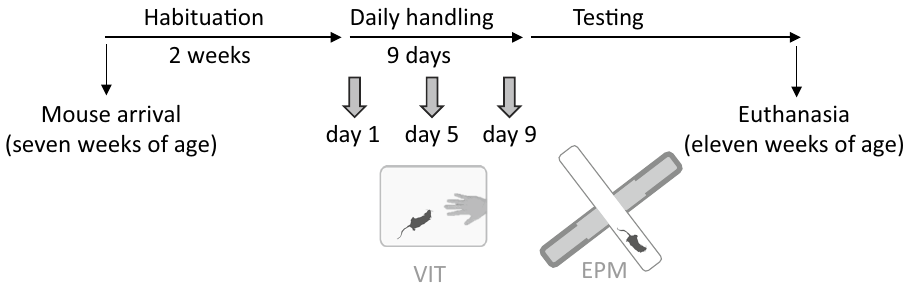
Figure 7. Timeline of Experiment 1. After habituation to the facility, the animals were handled daily for nine days. Animals were tested for voluntary interaction (VIT) three times during the handling period, and thereafter in an elevated plus-maze (EPM) test once. Mouse image reprinted from Scidraw doi.org/10.5281/